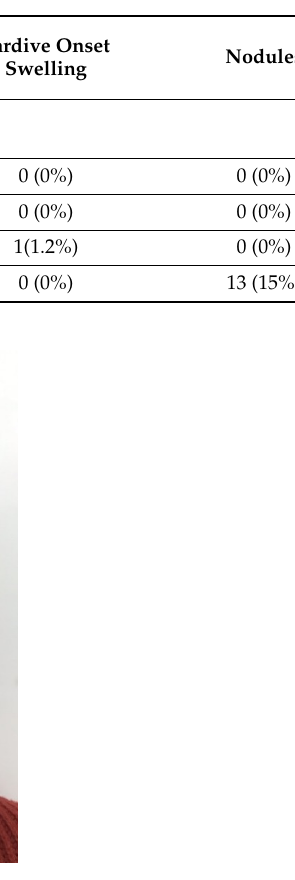
Figure 8. Bilateral huge abscess in a patient receiving polyacrylamide hydrogel injections 10 years after treatment.